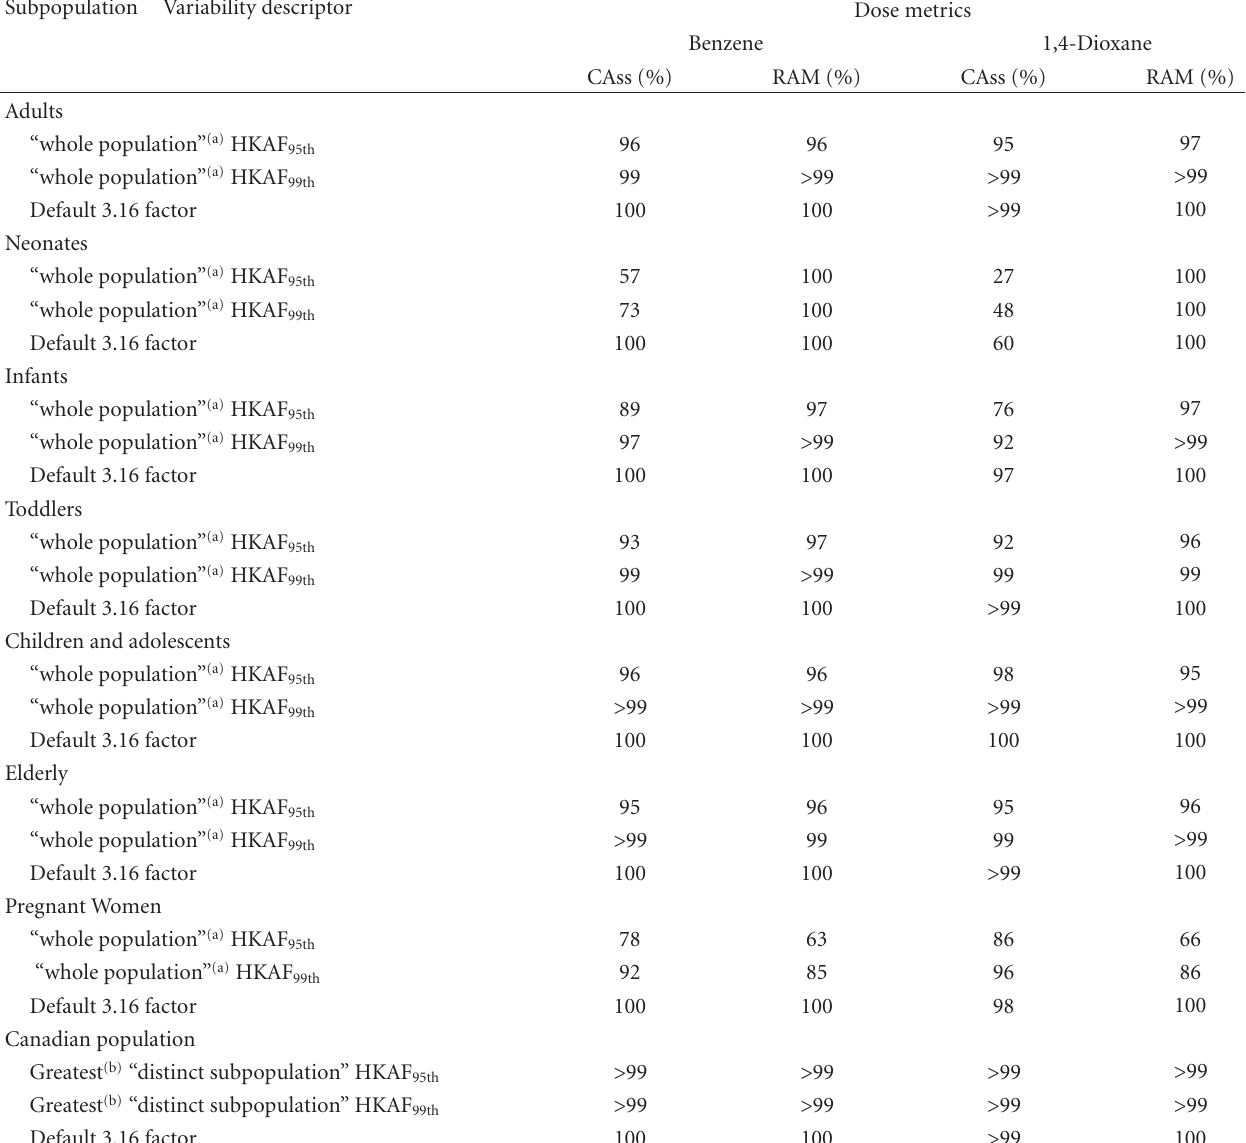
Table 6: Percentage of individuals in the diverse Canadian subpopulations that are covered by the HKAF and the default factor for various dose metrics and